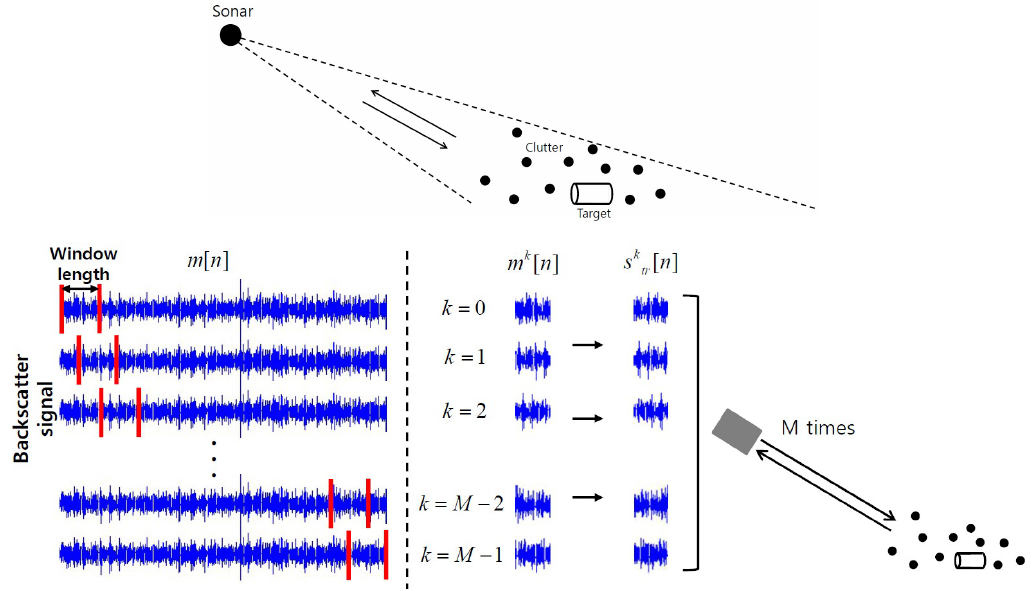
Figure 1. Schematic diagram of the implementation of the time-reversed retransmission